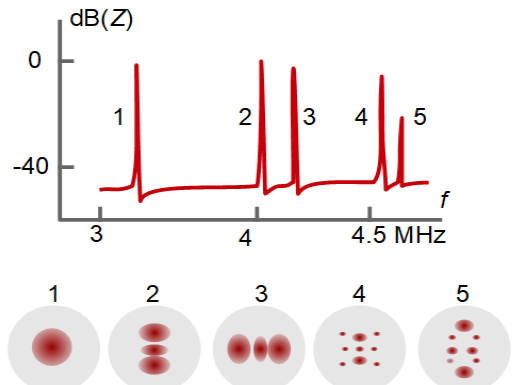
Figure 40. Vibrational patterns of the 1-00-mode (“1”) and a few anharmonic sidebands. The top shows | Z el | versus frequency. The mode shape was determined with a variant of optical reflec- tometry. Adapted from [183].